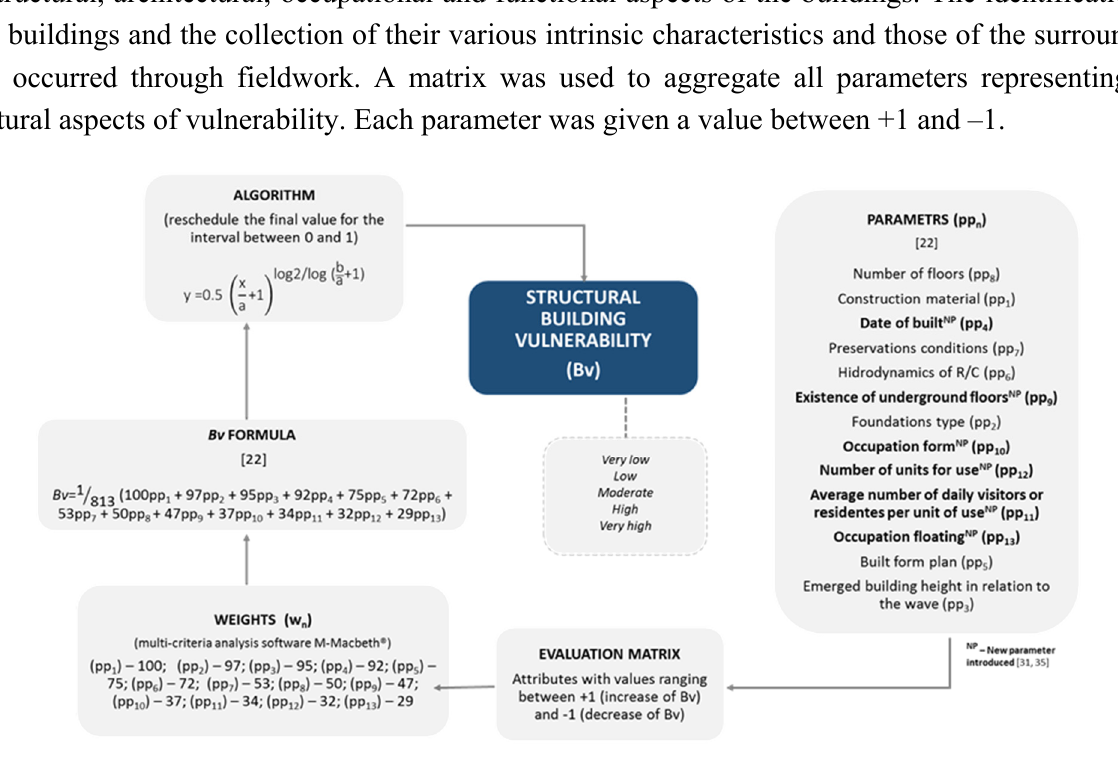
Figure 10. Graphical process of structural vulnerability calculation.